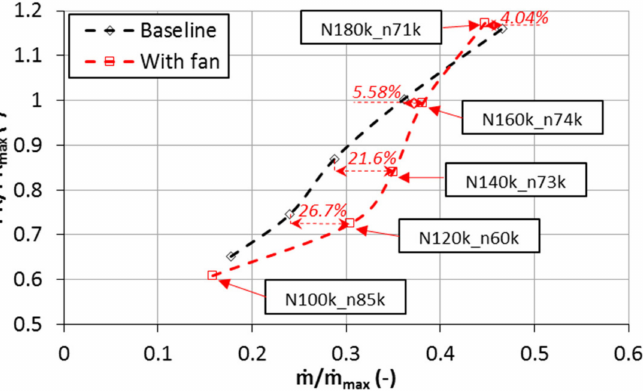
Figure 11. Comparison between baseline surge line and surge line with axial fan. (Reproduced with permission from Taylor & Francis Group, ©2021